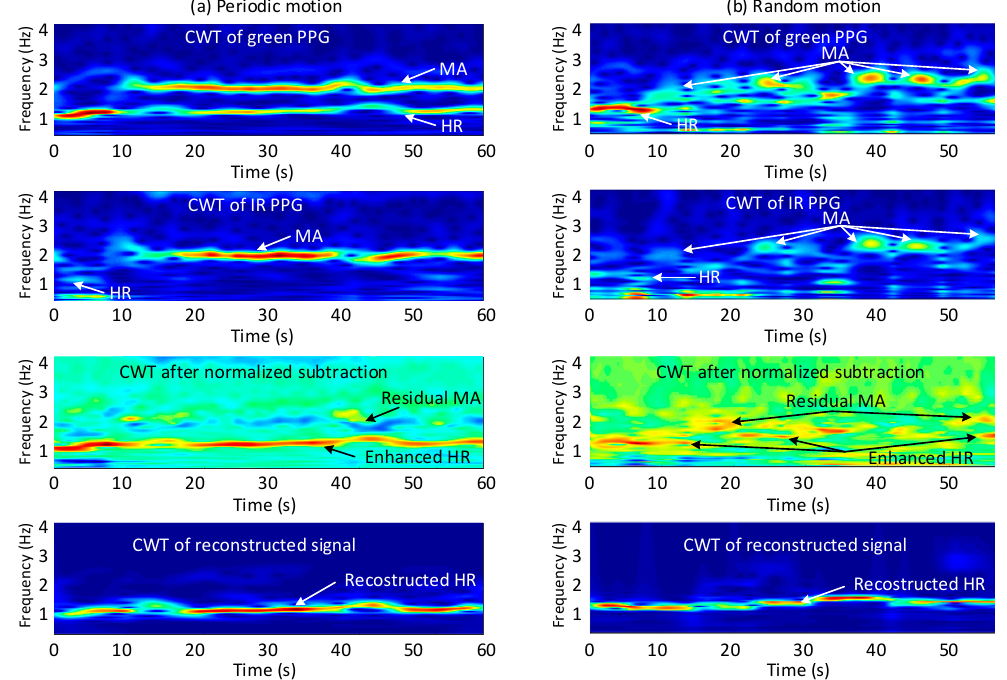
Figure 7. Motion reduction based on CWT: ( a ) Periodic motion type g; ( b ) Random motion type g. The first row shows the CWT of the green PPG signal during these two types of motion. The second row depicts the CWT of the IR PPG signal. The third row gives the CWT after normalized subtraction (Equation (3)). The last row shows the CWT of the reconstructed signal.